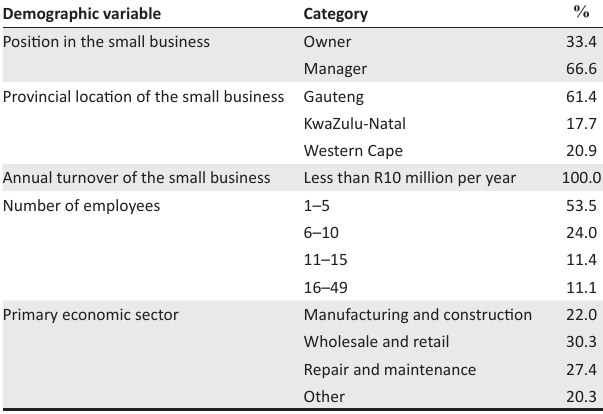
TABLE 1: Demographic information of